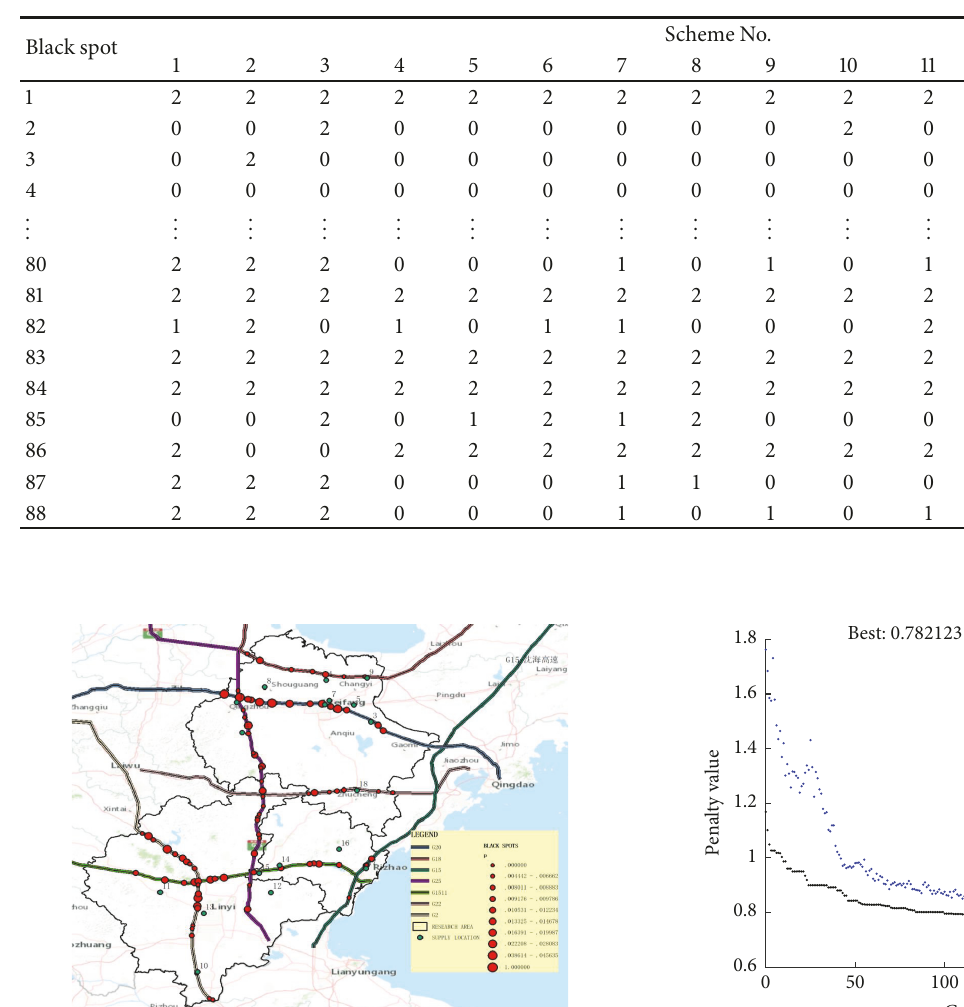
Table 6: The preliminary schemes.